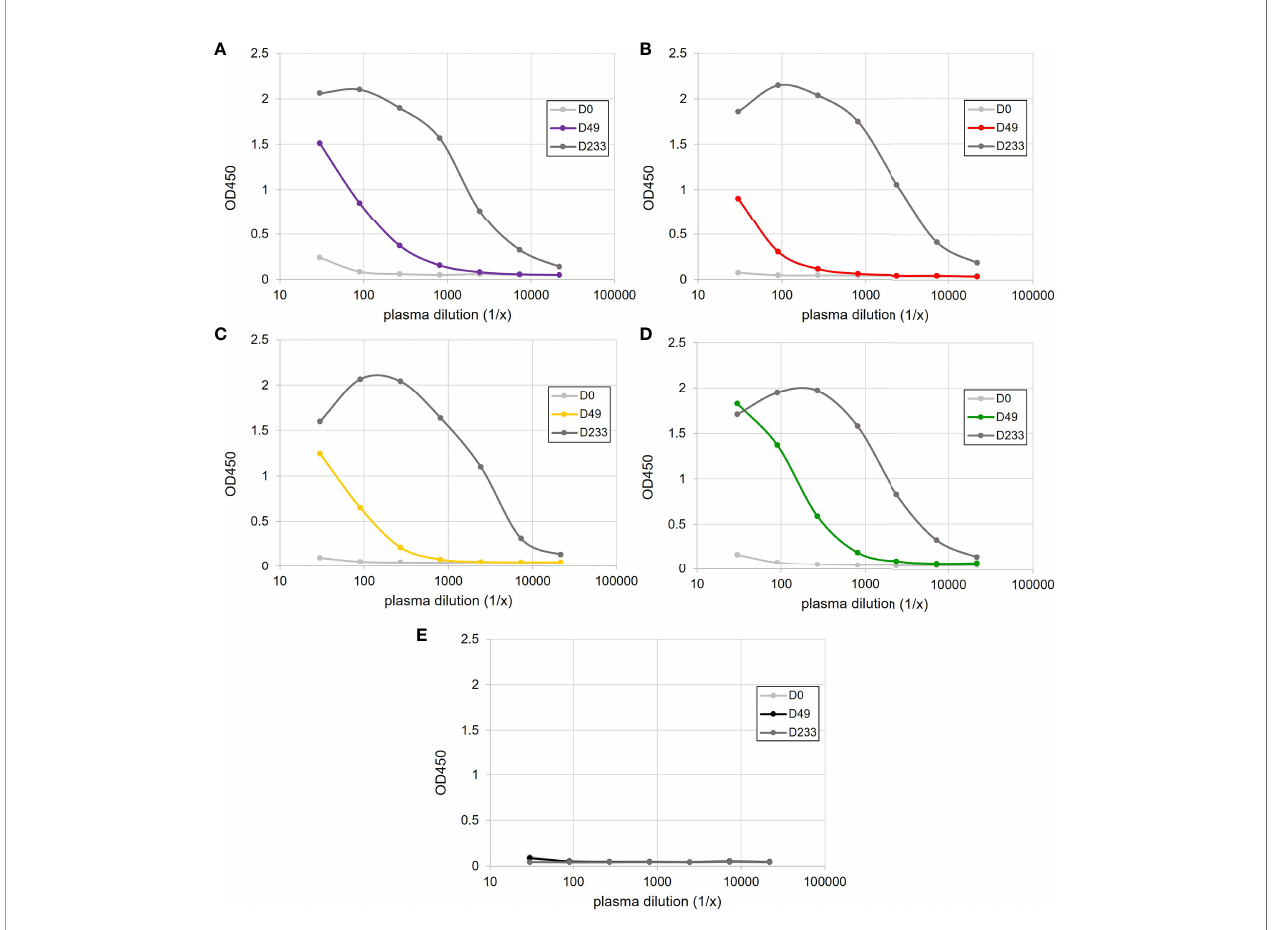
FIGURE 1 | Antigen-speci fi c IgM binding ELISAs following the immunization of four sharks, (A) Purple, (B) Red, (C) Yellow and (D) Green, with HSA-CFA and (E) a single sham-immunized shark. Plasma samples were taken prior to immunization (D0) and on days 49 (D49) and 233 (D233)